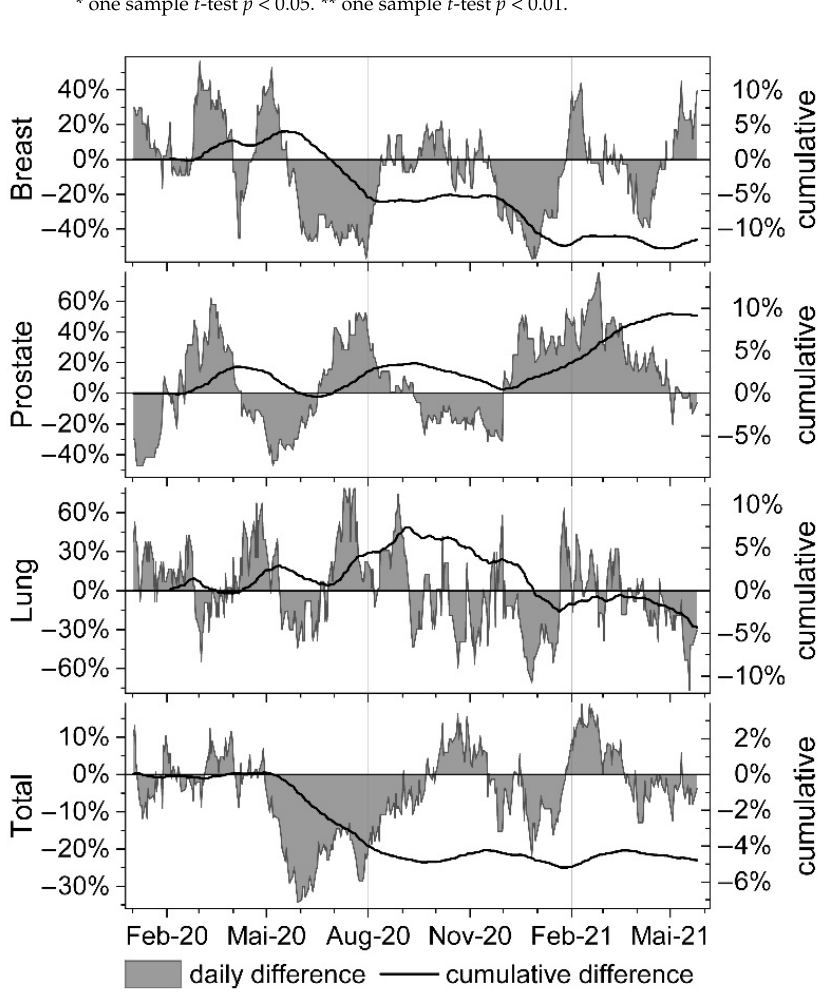
Figure 2. Relative and cumulative difference of total, as well as of breast, prostate and lung cancer- related RT sessions performed during the pandemic period in comparison to the reference months of 2018 and 2019. Area plot: daily relative difference.